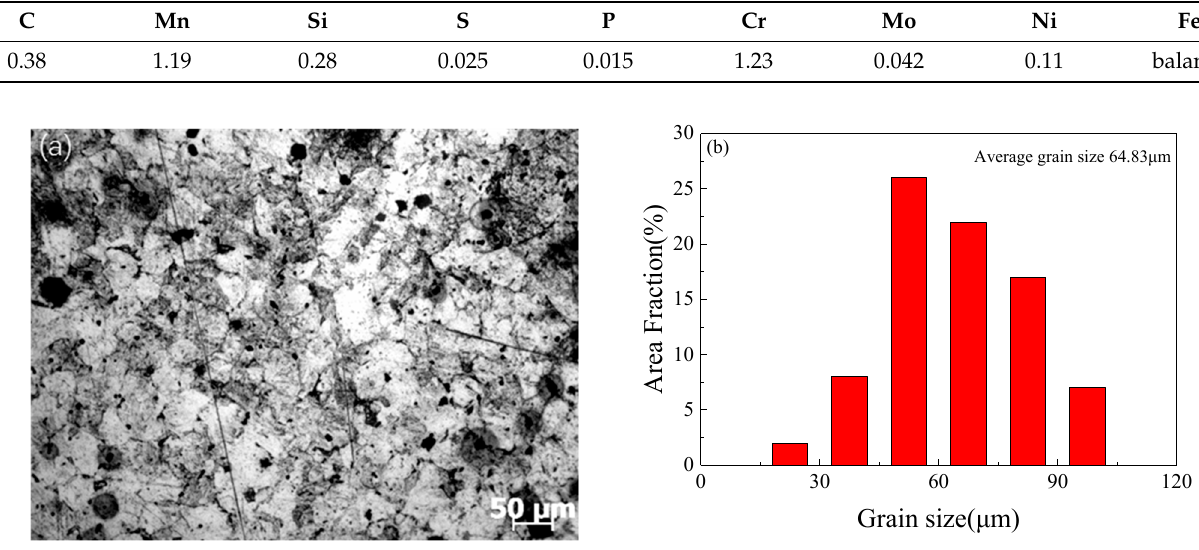
Figure 3. ( a ) Initial microstructure and ( b ) grain size distribution of the SAE 5137H steel. Table 1. Chemical compositions of SAE 5137H steel.